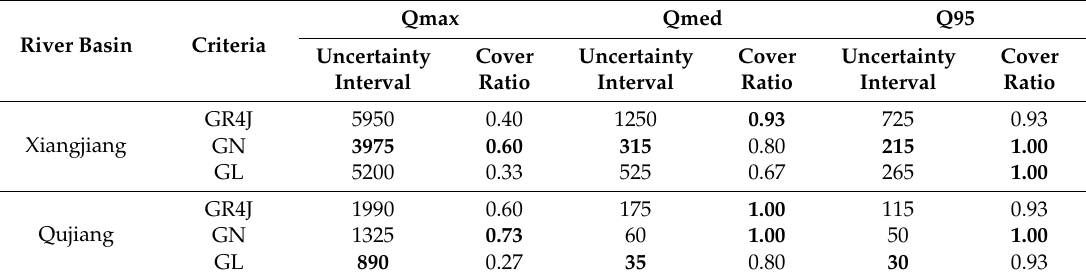
Note: Bold texts represent the best performance of the model in corresponding river basins.